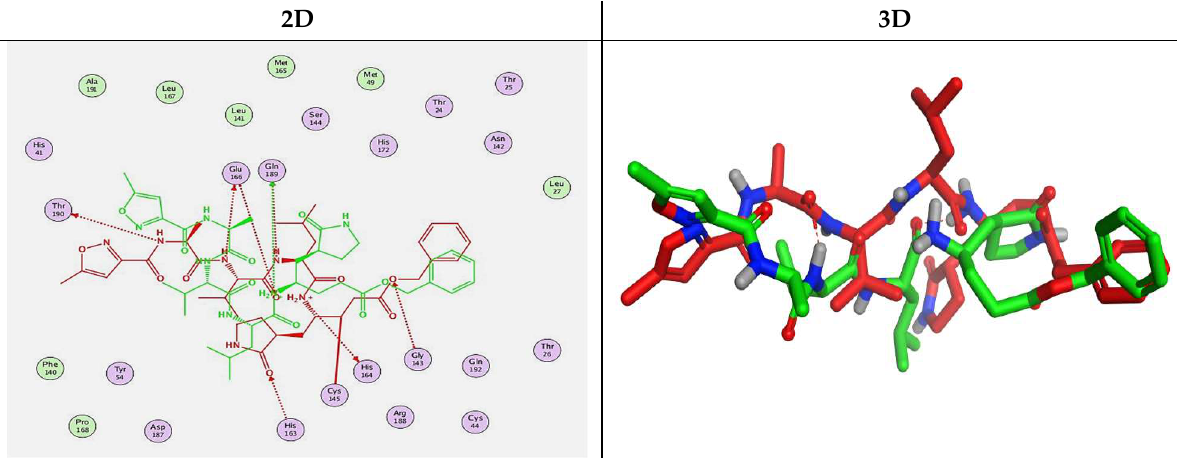
Figure 10. Superimposed poses of the docked N3 inhibitor (represented in green color) over the native co-crystallized one (represented in red color) produced from the redocking process inside the Mpro binding pocket. Left ( 2D ) and right ( 3D ) graphical representations.